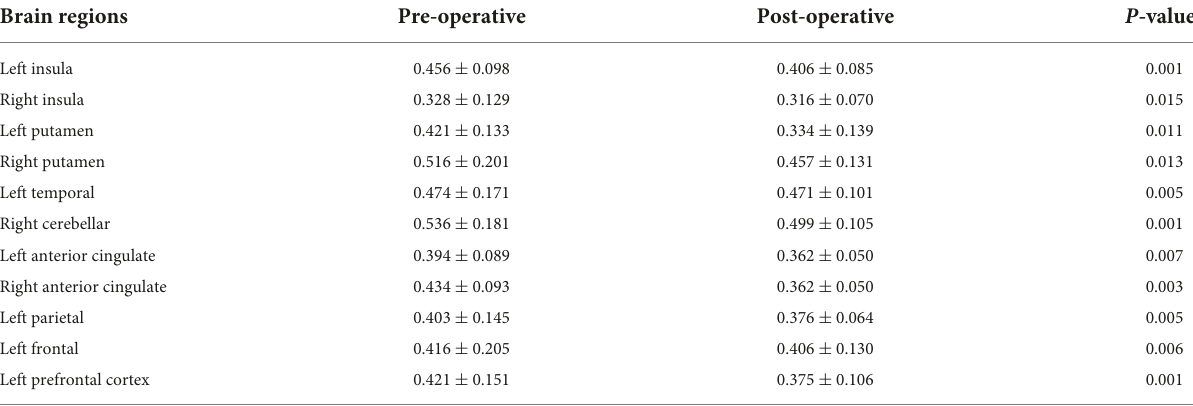
FIGURE2 Gray matter volume changes in pre- and post- lung transplant patients. Significant difference between group ( p < 0.05) is marked with asterisk ( ∗ ). ROI, region of interest.